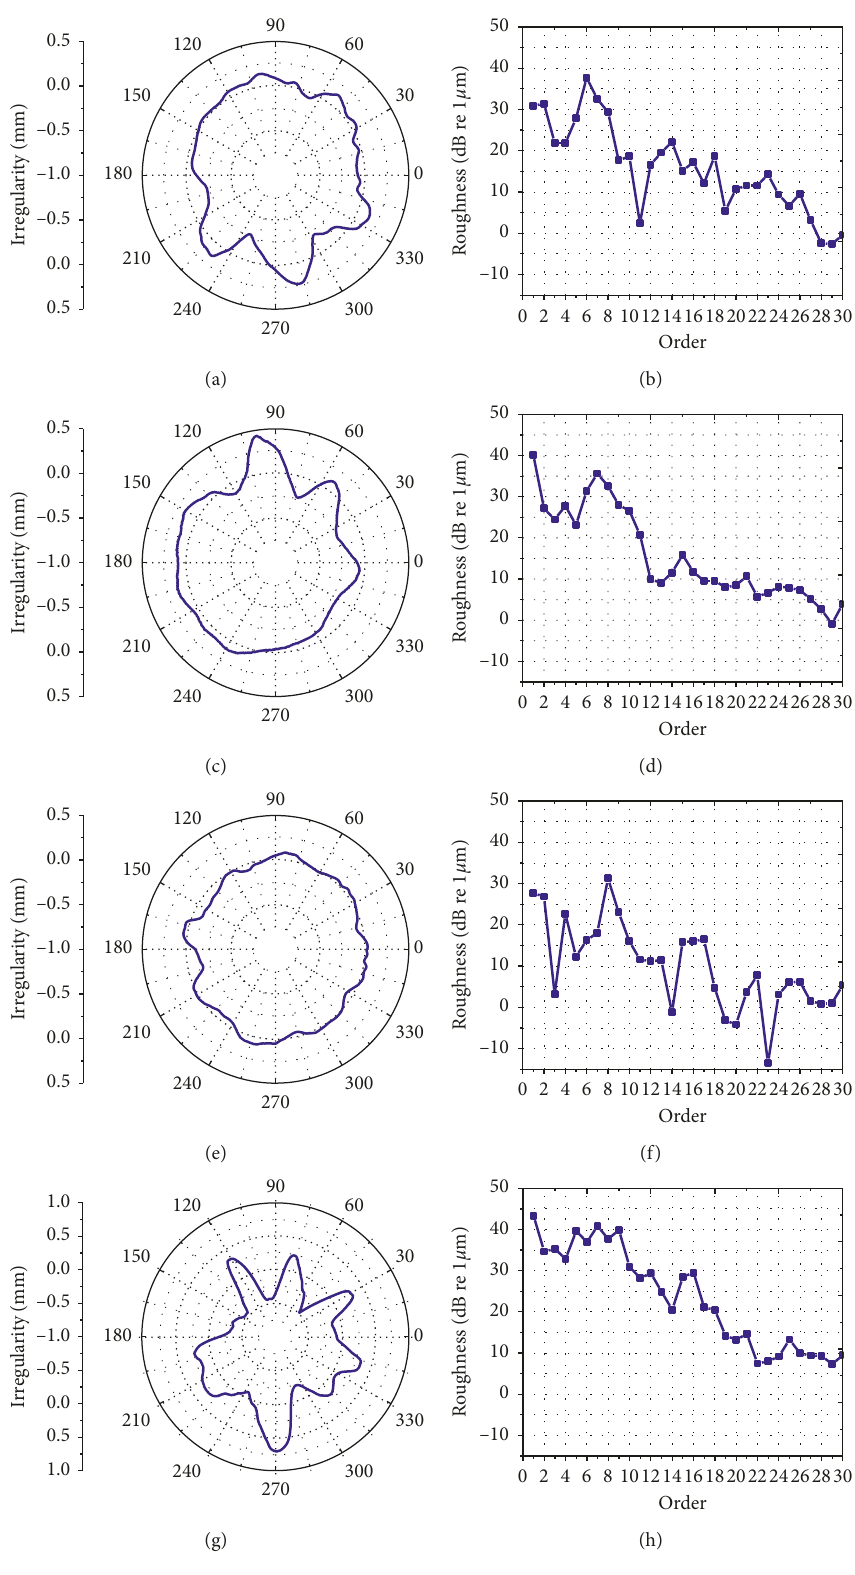
Figure 2: Typical types of wheel polygonalization measured on metro